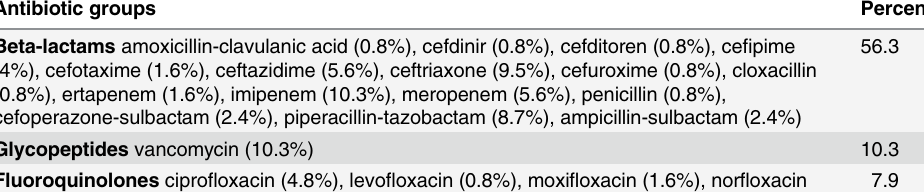
Table 1. Antibiotic exposure in the 2 month period preceding a diagnosis of CDI in patients. Antibiotic